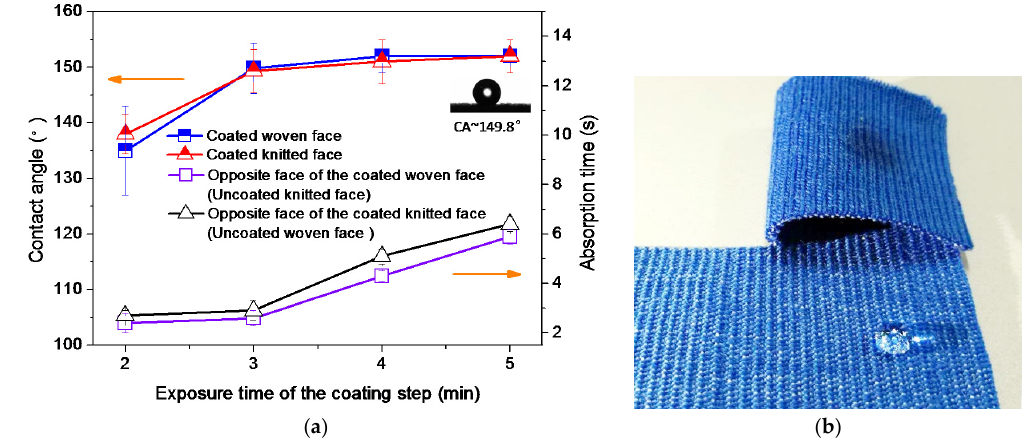
Figure 4. Water contact and absorption properties of bifacial fabric ( a ) effect of coating time on contact angle (CA) of the coated face and absorption time of uncoated face, error bars indicate standard deviation. Note the two different y ‐ axis scales. ( b ) A hydrophobic woven face (coated) and a hydrophilic knitted face (uncoated).